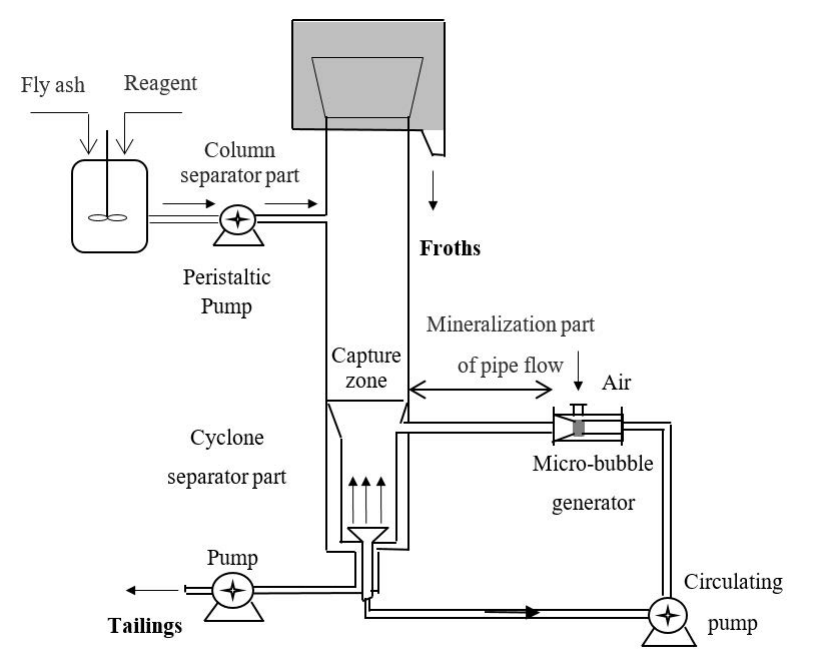
Figure 1. Schematic of the cyclonic-static micro-bubble flotation column (FCSMC)